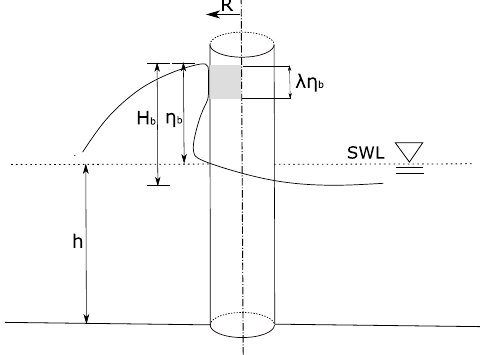
Figure 5. Impact area on a slender cylinder due to slamming force, as adapted from [43] with permission from Elsevier Ltd, UK,